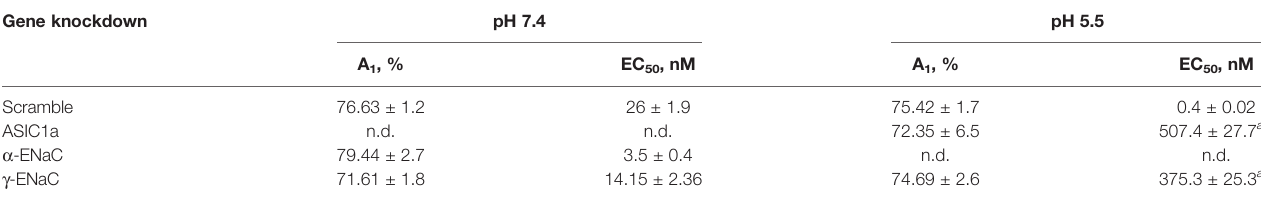
TABLE 1 | Parameters describing the effect of ASIC1a, a -ENaC, and g -ENaC knockdown on the anti-proliferative activity of mambalgin-2 in A549 cells. Gene